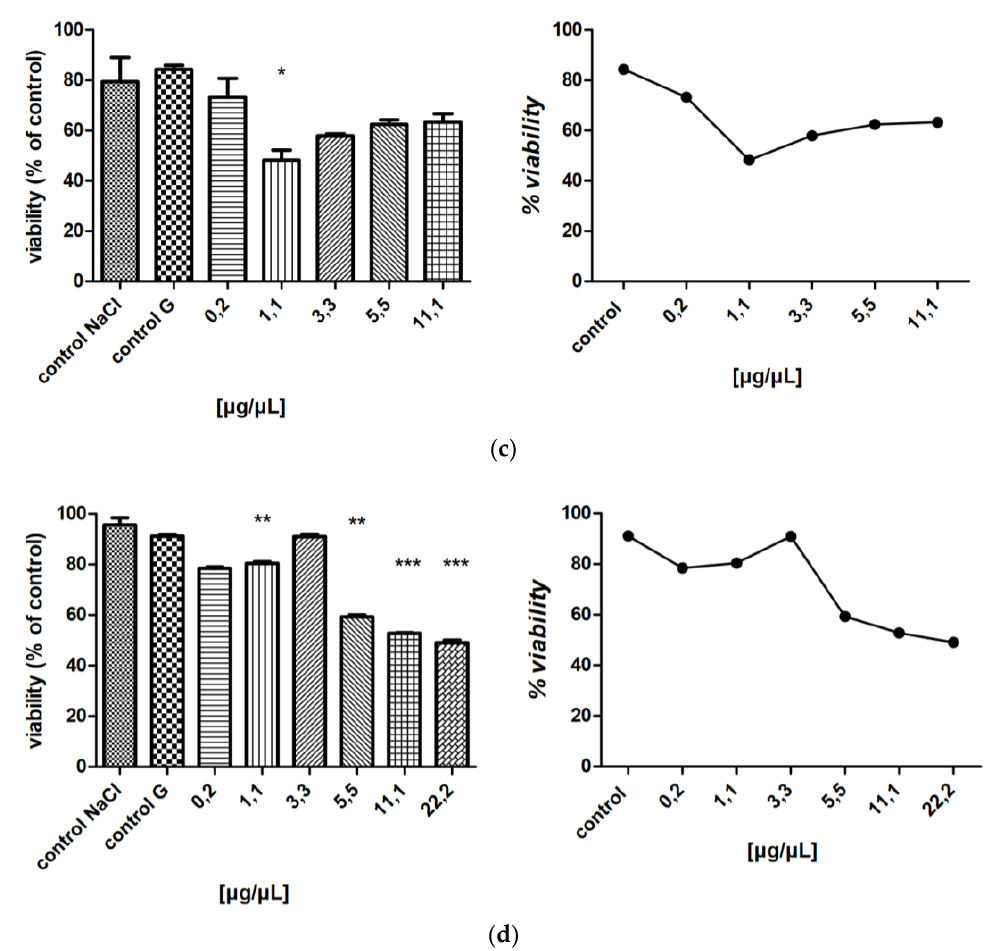
Figure 7. Viability (%) of Rhabditis sp. nematodes after 24 h exposure to increasing concentrations of the compounds ( a ) 12, ( b ) 14, ( c ) 18 and ( d ) albendazole [38,49] ( p < 0.05 *, p < 0.01 **, p < 0.001 ***).